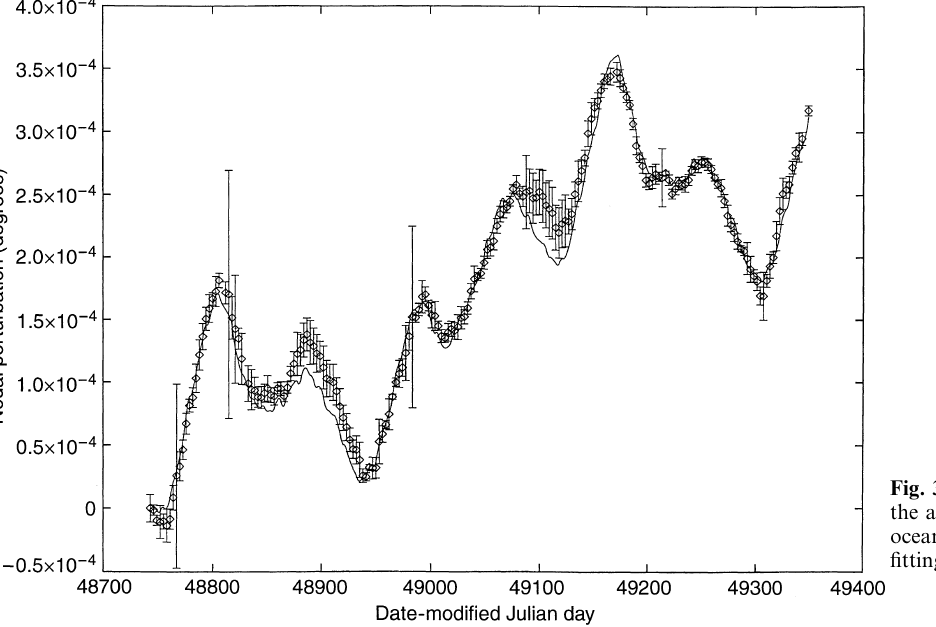
Fig. 3. The change in right ascension of the ascending node for Starlette due to